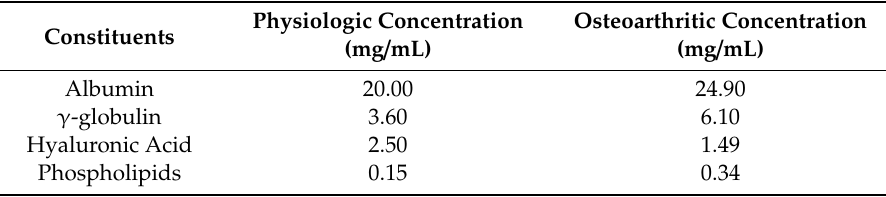
Table 2. Used concentrations of the constituents